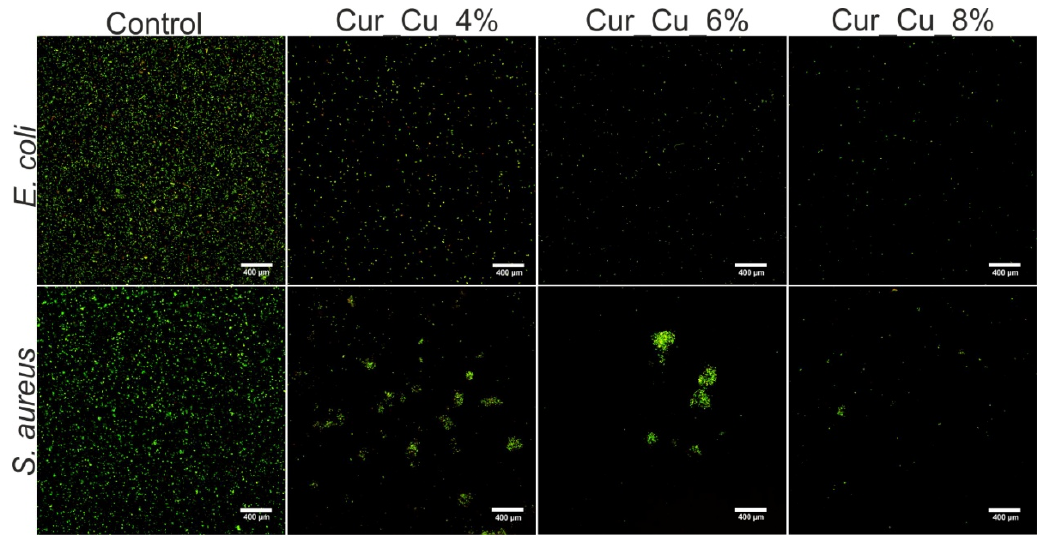
Figure 6. Representative images showing live (green fluorescence) bacteria— E. coli and S. aureus— after 24-h incubation with Cur_Cu_4%, Cur_Cu_6%, and Cur_Cu_8% biomaterials. The bacteria incubated without biomaterials were served as control of experiment. In all tested groups, none dead cells (red fluorescence) were visible. Magnification 400×, scale bar equals 400 μm.